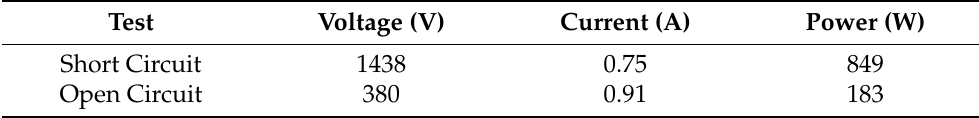
Table 1. Open and short circuit test measurements.